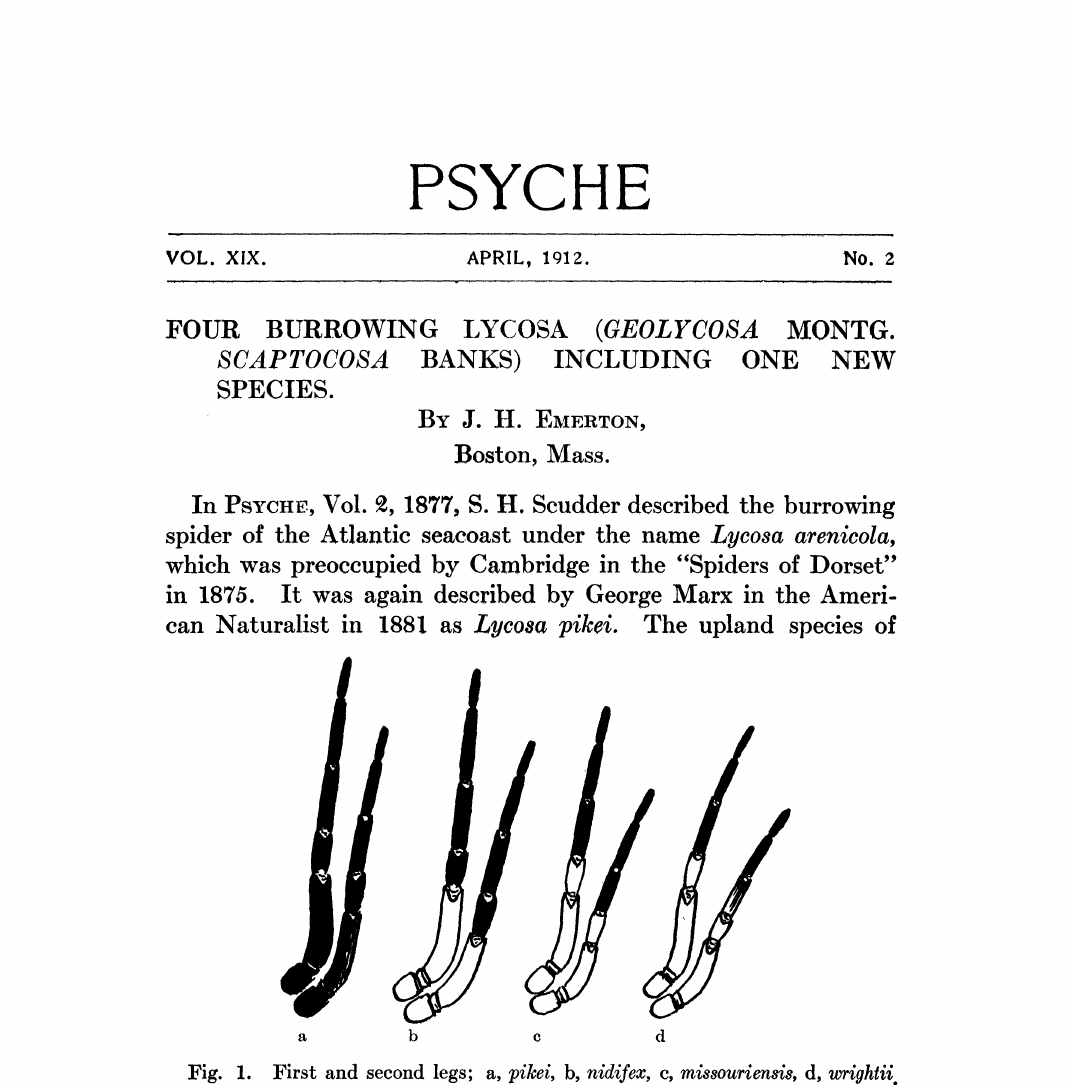
Fig. 1. First and second legs; a, pikei, b, nidifex, c, missouriensis, d, wrightii. the Eastern States was described by Marx at the same time with the name Lycosa